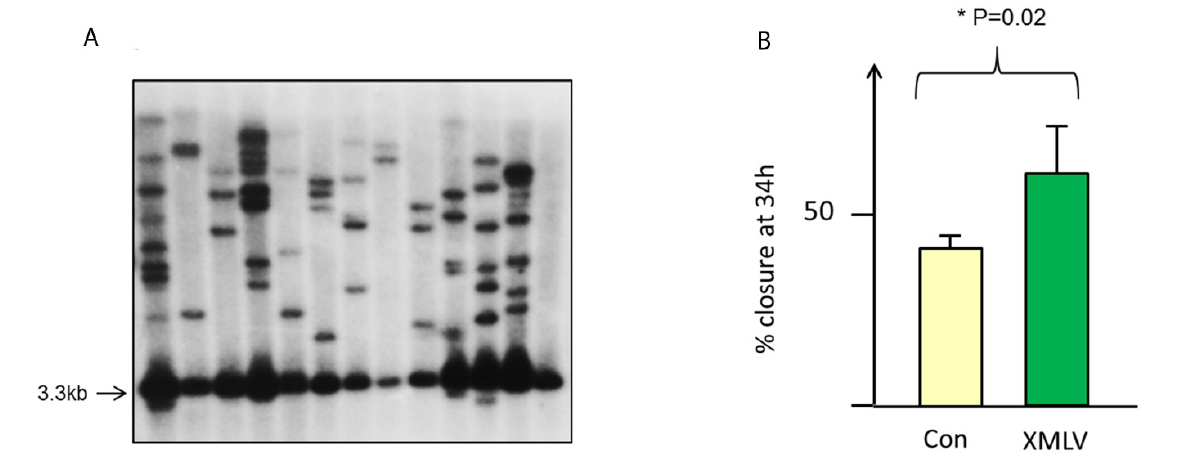
Figure 3. High copy number and phenotypic effects of XMLV in MCF7 cells. ( A ) Depicts Southern blot analysis of single cell clones of XMLV-infected MCF7 cells. DNA was digested with EcoRV and probed with an LTR- gag probe from XMLV. This analysis detects an internal genomic fragment of 3.3.kb and a series of unique integration host-virus junction fragments; ( B ) Accelerated wound healing in chronically infected MCF7 cells compared to control uninfected cells (significance was determined by unpaired t